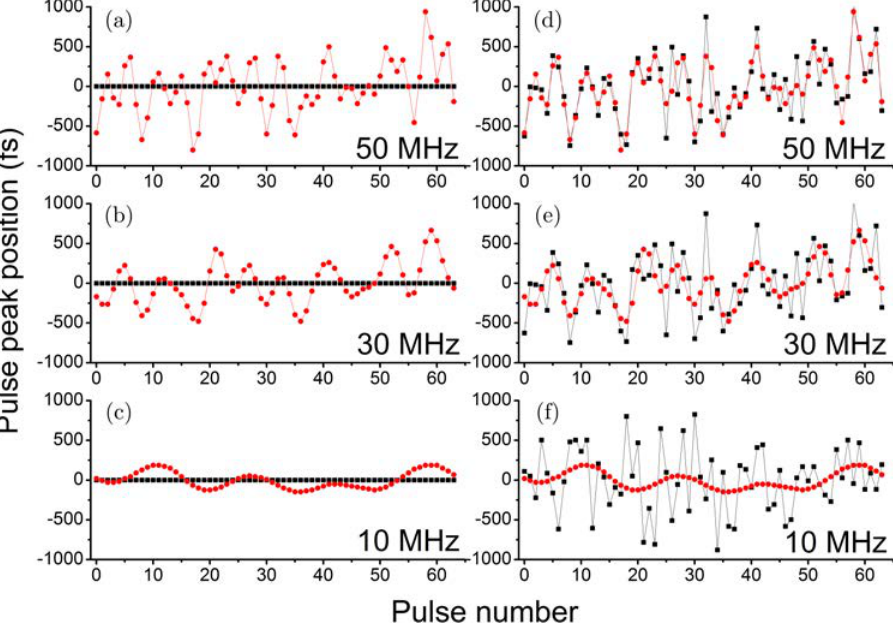
Fig. 4. Pulse peak positions of the mode-locked laser (black squares) and the synchronized time-lens source (red circles) with (a, d) 50-MHz, (b, e) 30-MHz and (c, f) 10-MHz RF ¯lter. In (a), (b) and (c), the relative timing jitter is due to the 400-fs electrical timing jitter introduced by the photodetector. In (d), (e) and (f), the relative timing jitter is due to the 400-fs intrinsic timing jitter introduced by the mode-locked laser.